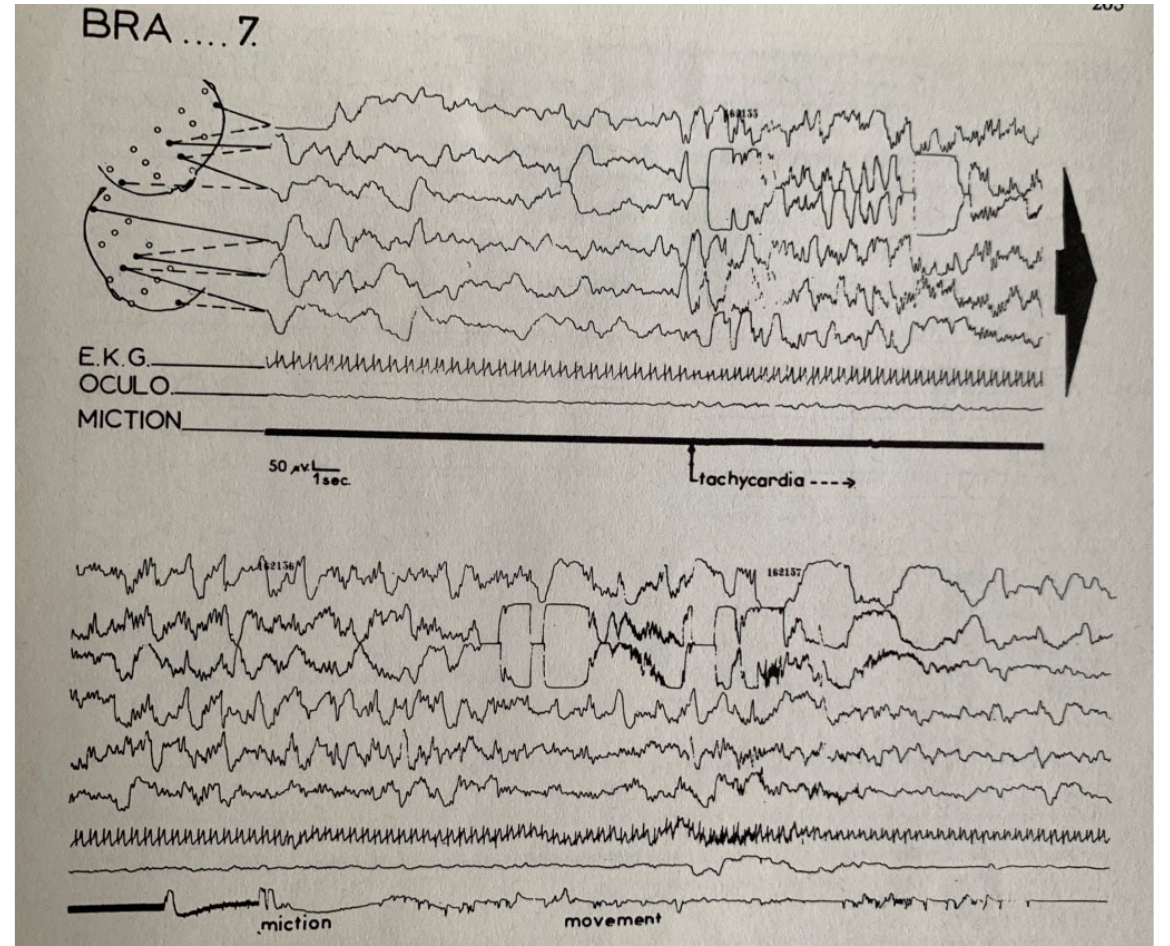
Figure 3. Polysomnographic recording of an enuretic episode in a 7-year-old girl. It begins in slow- wave sleep with a movement associated with an increased amplitude of the EEG slow waves and the onset of tachycardia. The channel “miction” shows the exact moment of onset of enuresis where the dark 50 Hz artifact becomes a thin line. There is further movement and the patient continues to be in NREM sleep (Adapted from Gastaut, H. and Broughton, R.: A clinical and polygraphic study of episodic phenomena during sleep. Academic Address, in: Wortis, J. (Ed.), Recent Advances in